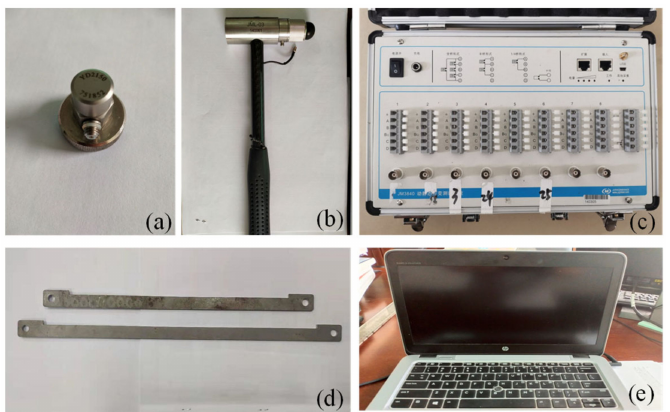
Figure 4. Experimental facilities: ( a ) accelerometers; ( b ) hammer; ( c ) JM3840 dynamic data acquisition instrument; ( d ) damaged flat steel bars; ( e )